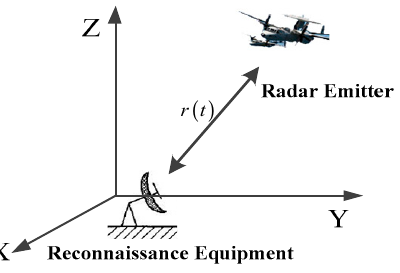
Figure 1. Relationship between the reconnaissance equipment and the radar emitter.